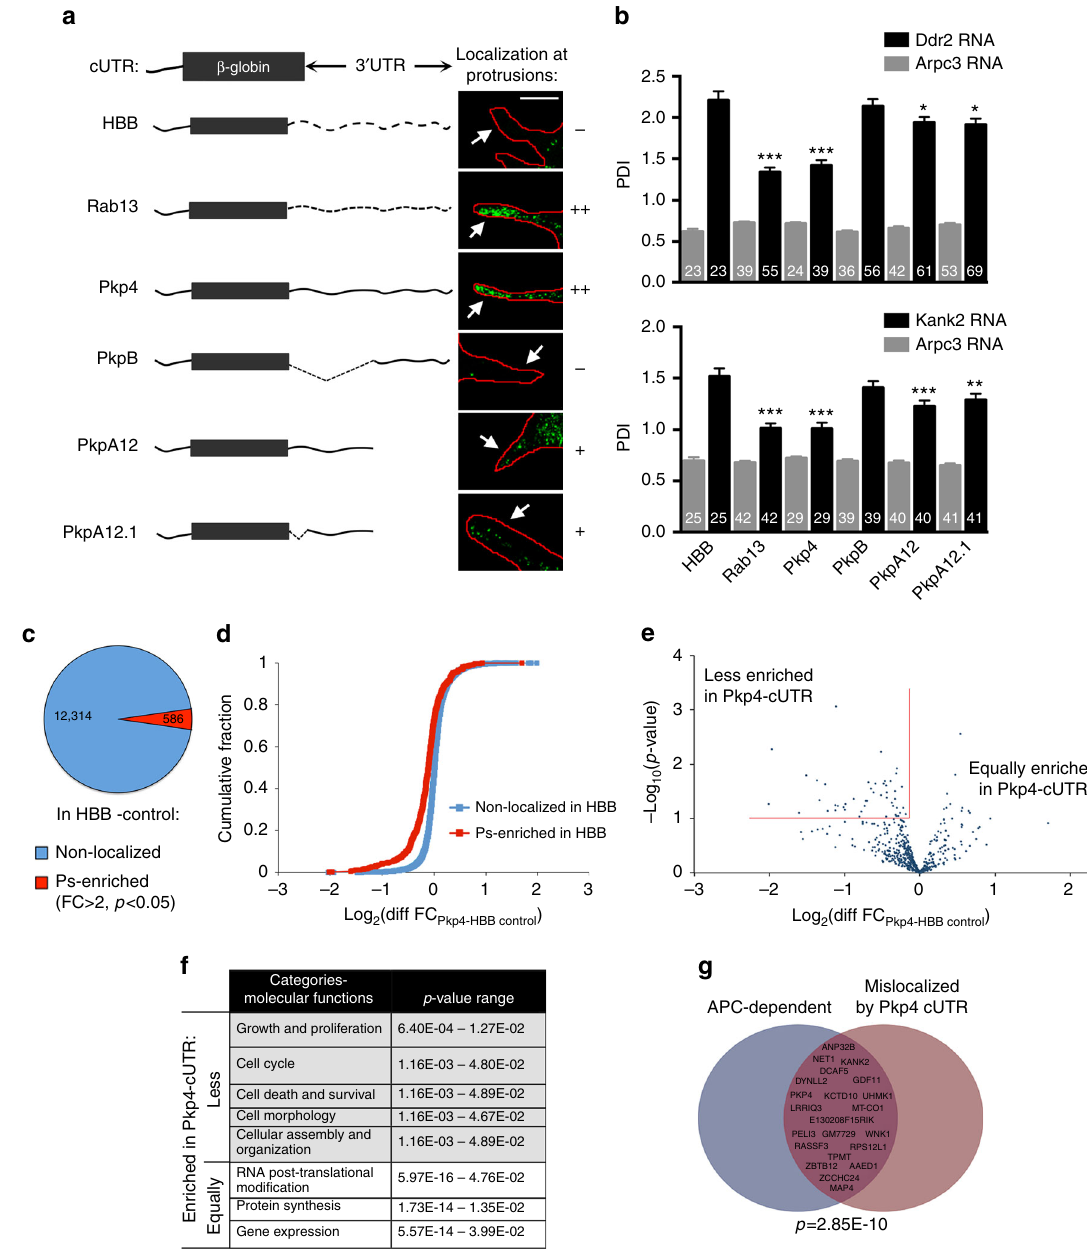
Fig. 7 A competition-based approach preferentially mislocalizes APC-dependent RNAs from protrusions. a Schematic of exogenously expressed constructs containing the β -globin coding sequence followed by the indicated 3 ′ UTRs ( β -globin UTR (HBB; spaced dashed line); Rab13 UTR (dashed line), Pkp4 UTR (solid line), or deletion fragments of Pkp4 UTR (PkpB, PkpA12, and PkpA12.1)). Representative in situ hybridization images detecting the β -globin RNA, and the ability of each construct to localize at protrusions are shown. Images focus on individual protrusions. Scale bar: 10 μ m. Whole-cell images and PDI values are shown in Supplementary Fig. 7a, b. b Cell lines, stably expressing β -globin constructs with the indicated UTRs, were analyzed by in situ hybridization and RNA distributions were assessed through PDI quantitation. (Ddr2, Kank2: APC-dependent RNAs; Arpc3: control, diffuse RNA). N -values of observed cells, from at least 3 independent experiments, are indicated within each bar. Error bars: standard error. p -values: *** < 0.001, ** < 0.01, * < 0.05 by analysis of variance with Dunnett ’ s multiple comparisons test. c Pie chart of non-localized or Ps-enriched RNAs in control HBB cells from 4 replicate experiments. Cutoffs for Ps-enrichment were set at FC > 2 and p -value < 0.05. d Cumulative fraction plot of log2 fold-change differences between control HBB and Pkp4 cUTR-expressing cells, for RNAs non-localized or localized in protrusions of control HBB cells. e For all Ps-localized RNAs of control HBB cells, the log 2 differences in FC values, between HBB control and Pkp4 cUTR-expressing cells, were plotted against the corresponding p -values. Applying the cutoffs marked by the red lines (see Supplementary Data 3 for details), Ps-localized RNAs were distinguished into groups less- or equally-enriched in protrusions upon Pkp4 cUTR expression. f Categories of molecular functions, derived through IPA analysis, signi fi cantly represented in RNA groups equally- or less-enriched in protrusions of Pkp4 cUTR-expressing cells. g Results of differential enrichment analysis showing signi fi cance of overlap between APC-dependent RNAs and RNAs mislocalized upon Pkp4 cUTR